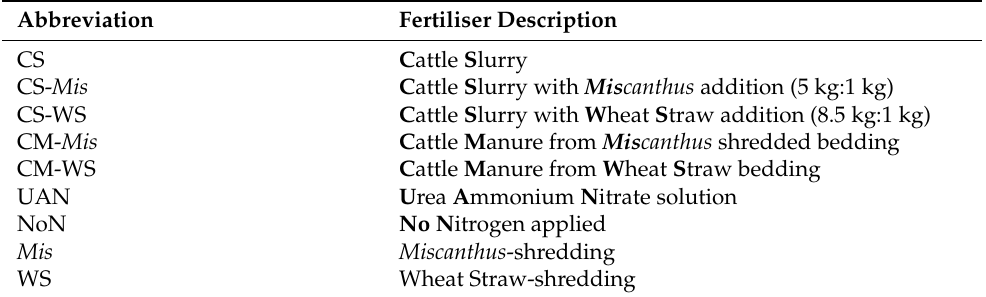
Table 2. Abbreviation and description of the fertiliser products and fertiliser feedstocks ( Mis , WS) evaluated in the greenhouse experiments.